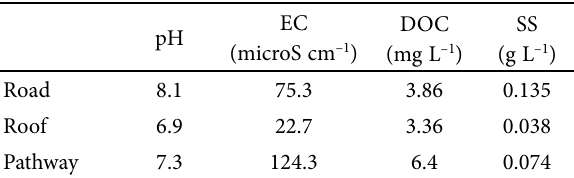
Table 4. Summary of the data from the three sampling sites for the mean value of suspended solids (SS), dissolved organic carbon (DOC), electric conductivity (EC), and pH EC DOC SS pH (microS cm –1 ) (mg L –1 ) (g L –1 ) Road 8.1 75.3 3.86 0.135 Roof 6.9 22.7 3.36 0.038 Pathway 7.3 124.3 6.4 0.074